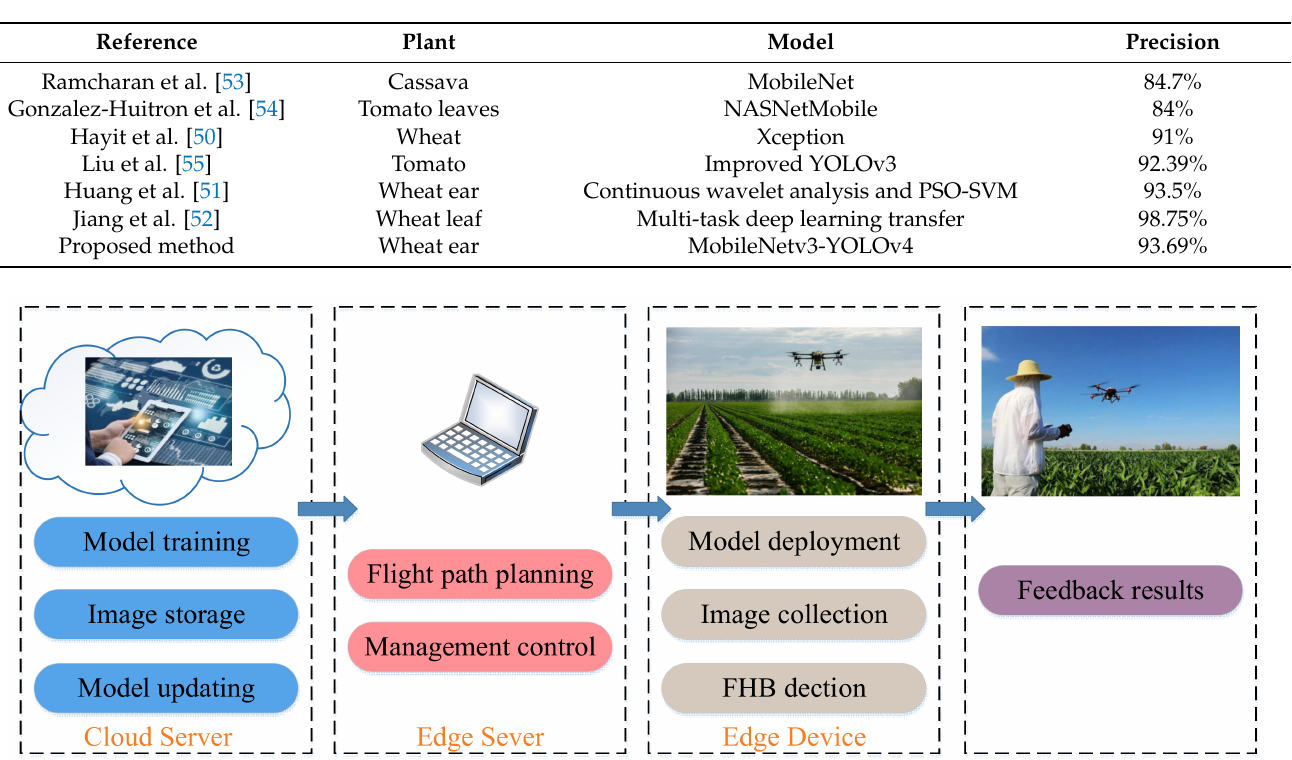
Table 4. Performance comparison of the proposed model with previous studies.